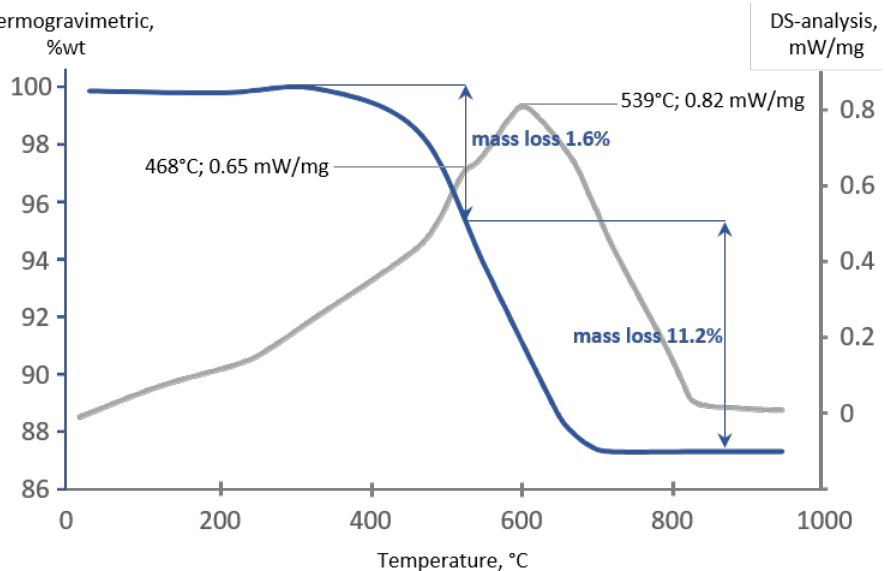
Figure 3. Adsorbent Thermogravimetric/Differential Thermal Analysis (TG/DTA).